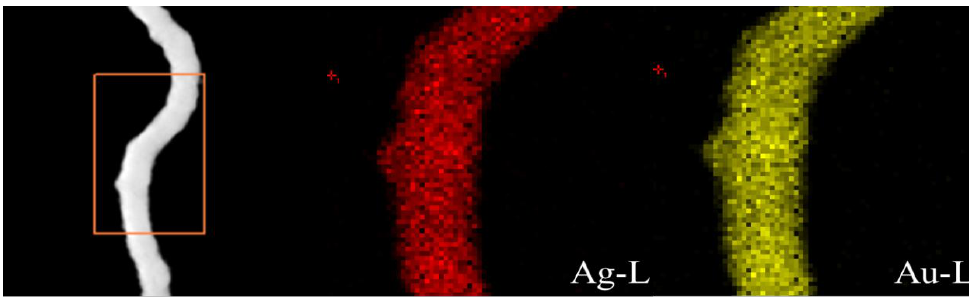
Figure 4. Scanning transmission electron microscope mapping (STEM) image of the single Au-Ag NW synthesized at 30 °C.